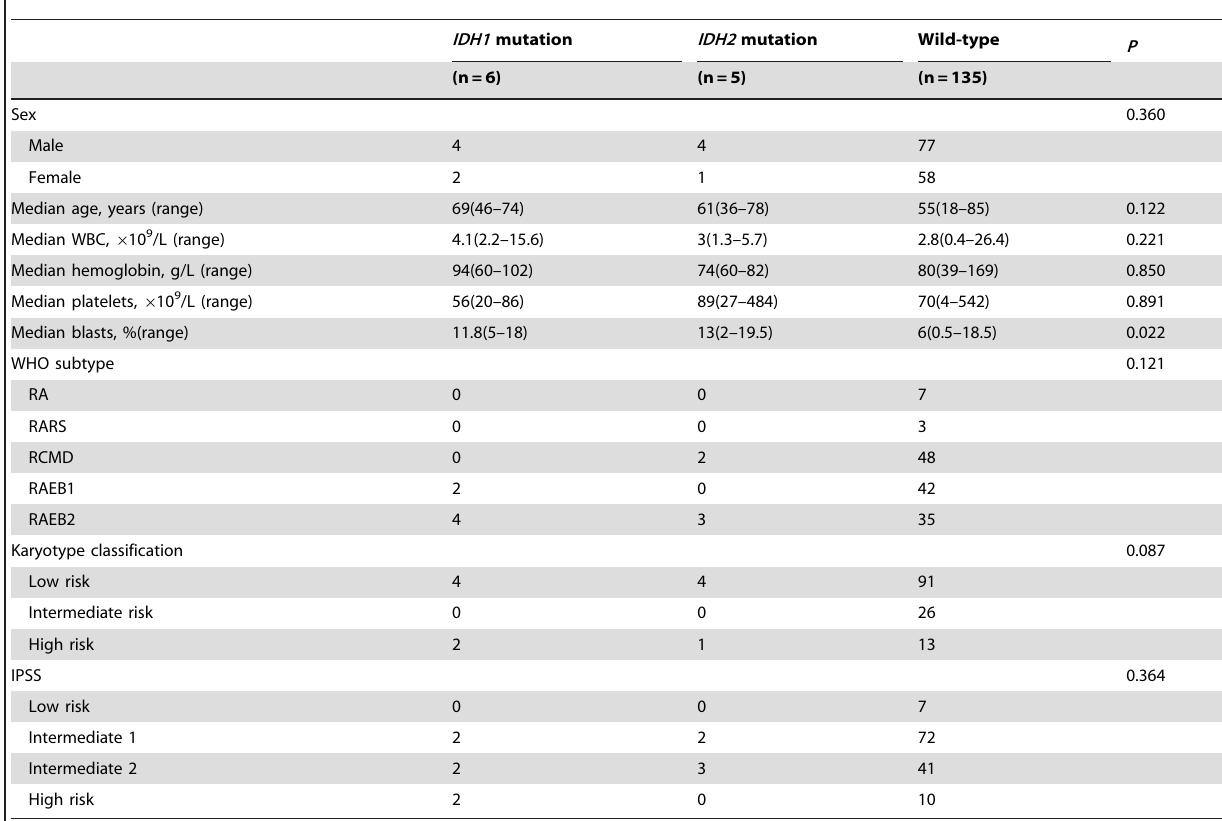
Table 1. Characteristics of patients with